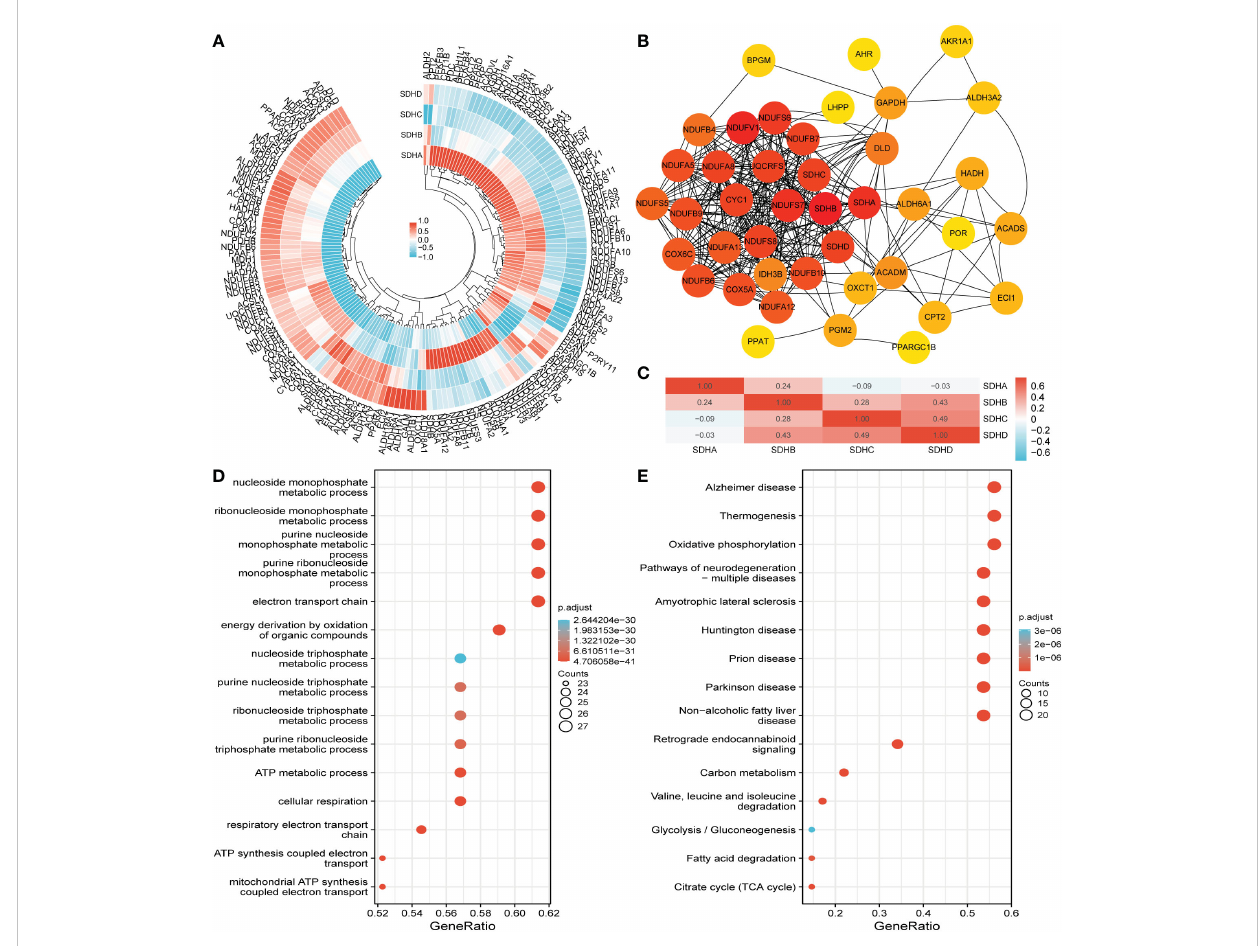
FIGURE 4 Correlation, functional enrichment based on MMGs. (A) The correlation between MMGs and SDHs in COAD. (B) The network for 41 genes is based on SDHs and MMGs with the highest correlation. (C) The correlation between different SDHs in COAD. (D, E) The functions and pathways based on 41 genes were predicted by the analysis of GO and